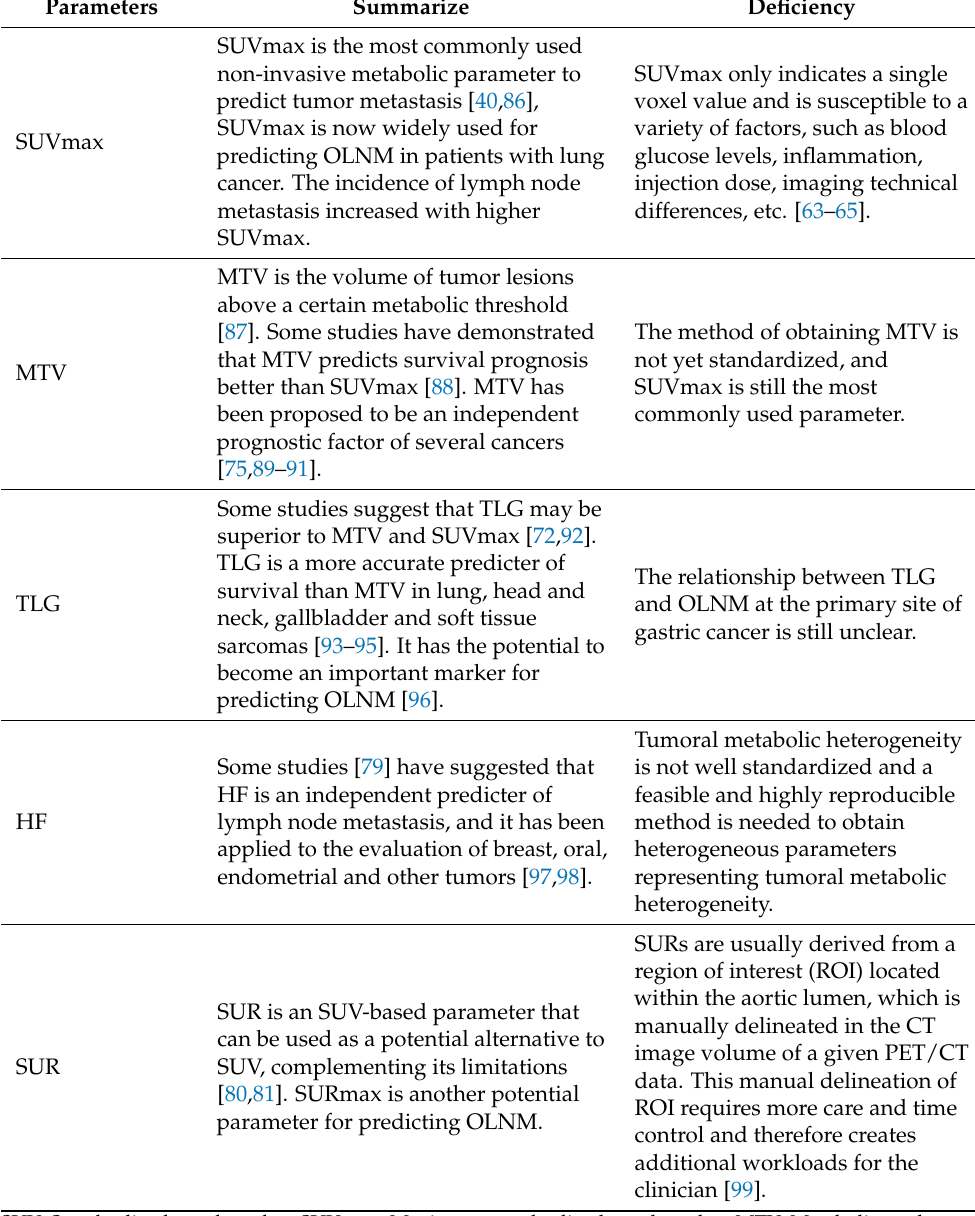
Table 2. Summary of the characteristics of various 18 F-FDG PET/CT